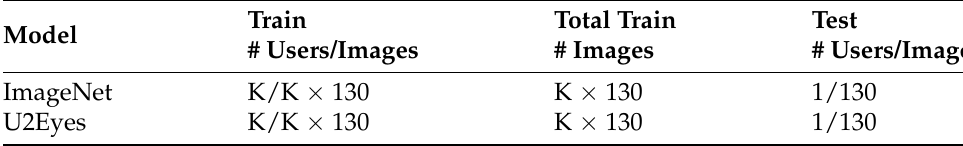
Table 3. New configurations of the different experiments according to the training mode, U2Eyes or ImageNet, and the number of users and images in the training and testing phase. In this new case, the K parameter varies from 1 to 11, as zero was reserved when training only with the calibration user. Additionally, there is no “Calibration #Users/Images” column as calibration is not conducted. The only images in the training dataset comes from users different from the test